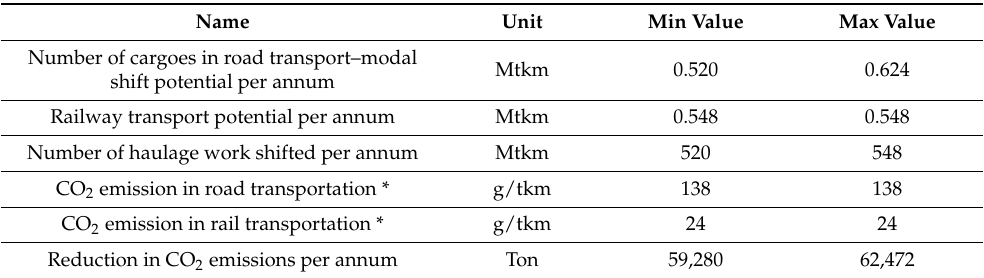
Table 3. Cumulative information resulting from the comparison of the susceptibility of cargoes to modal shift and the railway potential in the selected